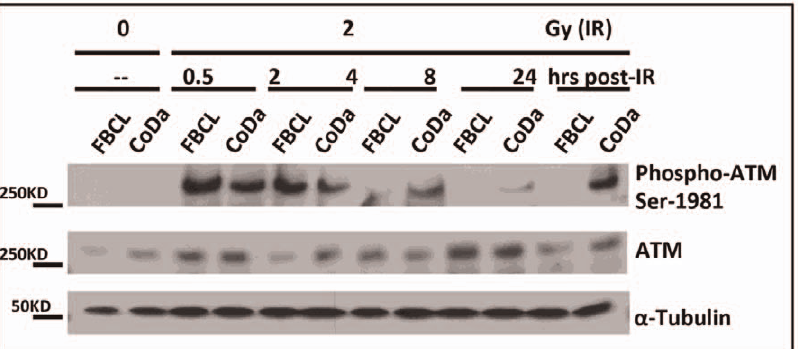
Figure 6. Normal activation but with delayed recovery of ATM in response to irradiation but with delayed recovery. FBCL (Control) and CoDa cells were treated with 2 Gy c -rays and harvested at 0.5, 2, 4, 8 and 24 hours after IR for whole cell extract preparation. The protein samples were subjected to SDS-PAGE, then the membrane was blotted with antibodies specified in the figure, including ATM and phosphorylated ATM at Ser- 1981, and a -tubulin was used as loading